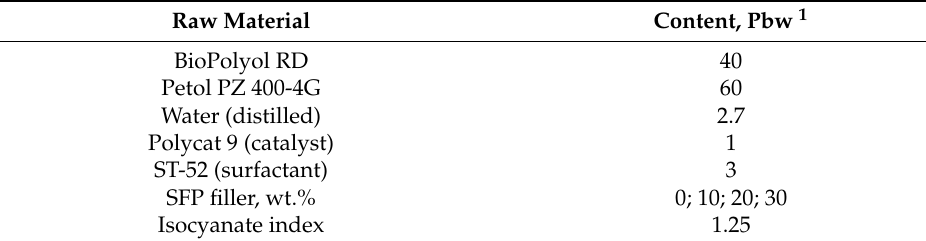
Table 1. Formulations of PUR foam and SFP filler-modified PUR foams.